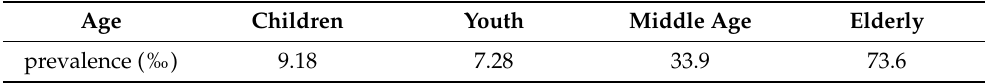
Table 1. Two-week prevalence for different age